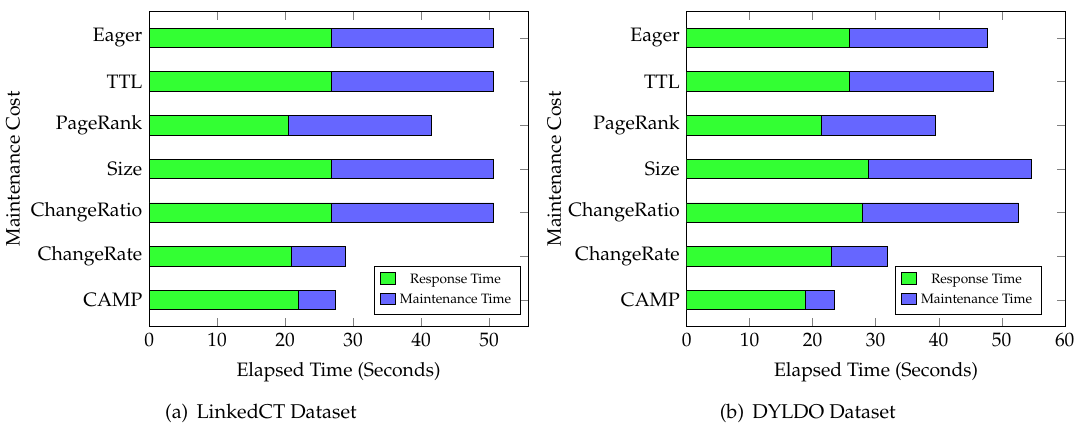
Figure 3. Maintenance cost: Showing the comparison with other state-of-the-art approaches on ( a ) LinkedCT and ( b ) DYLDO